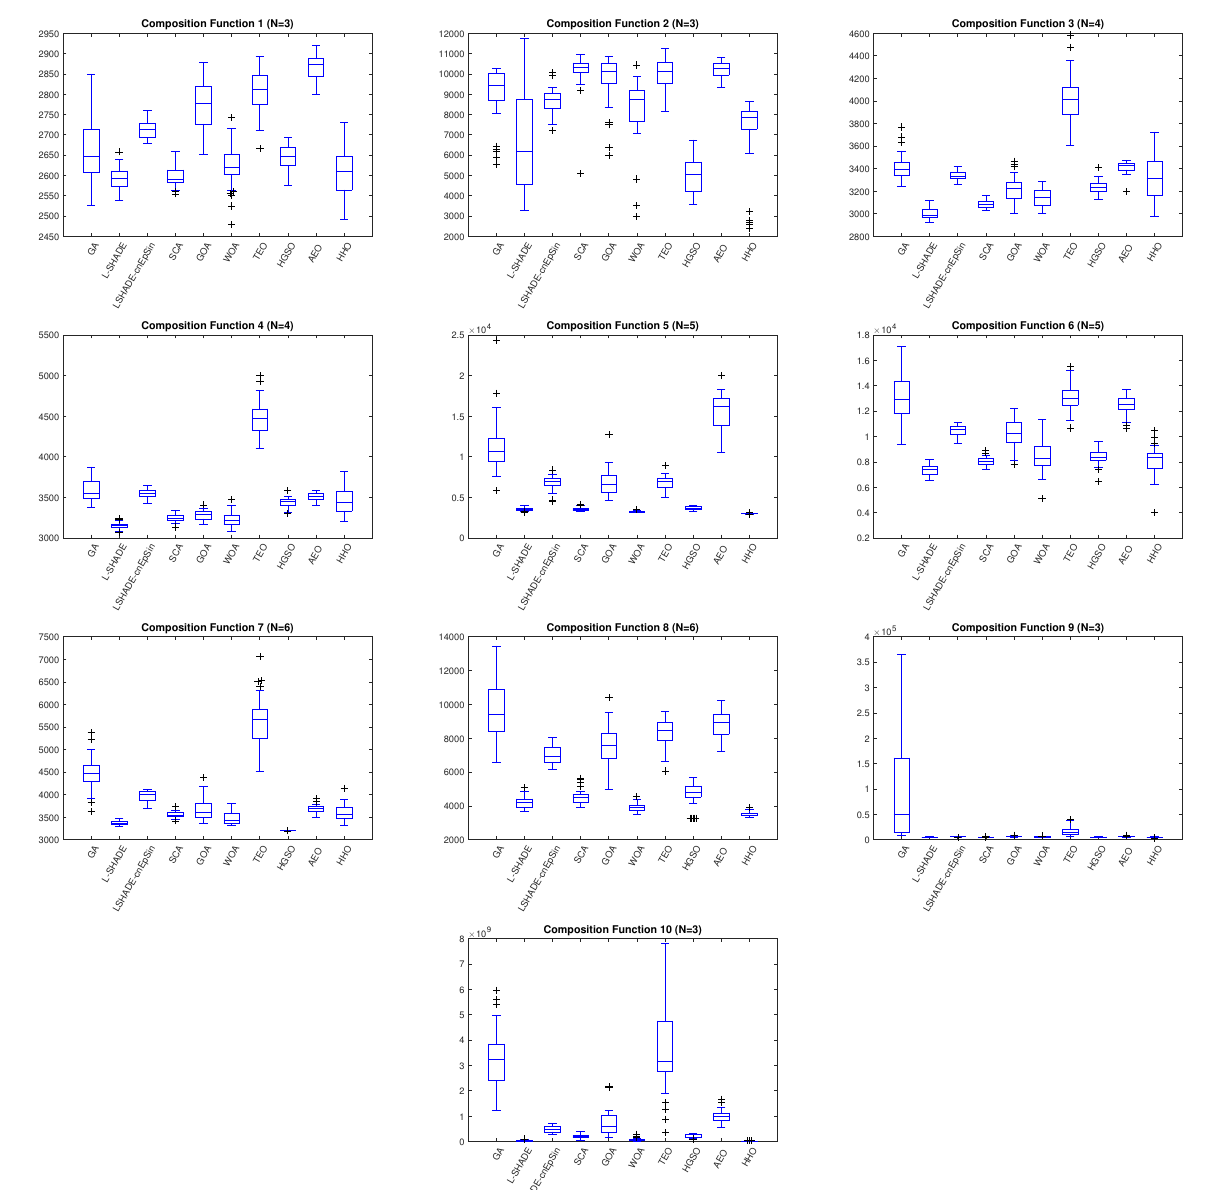
Figure 11. Boxplot of some functions from F21–F30 for all